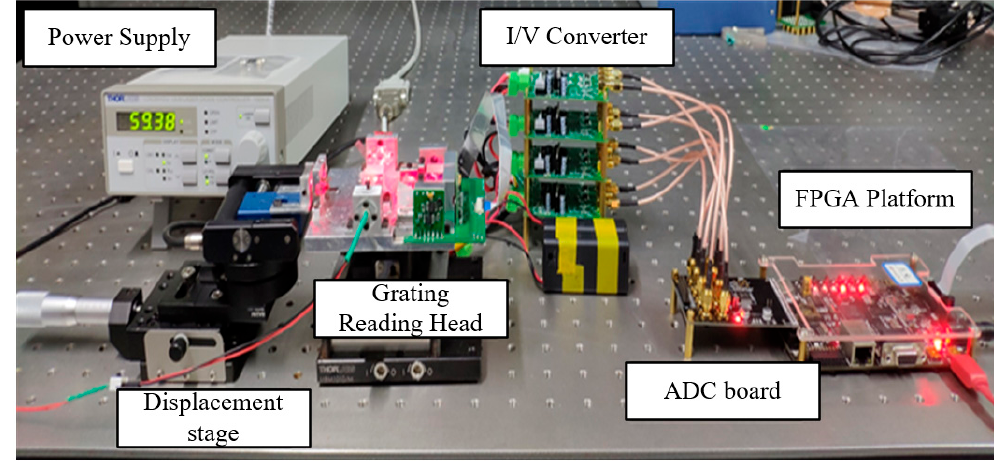
Figure 4. Hardware platform and experimental device.